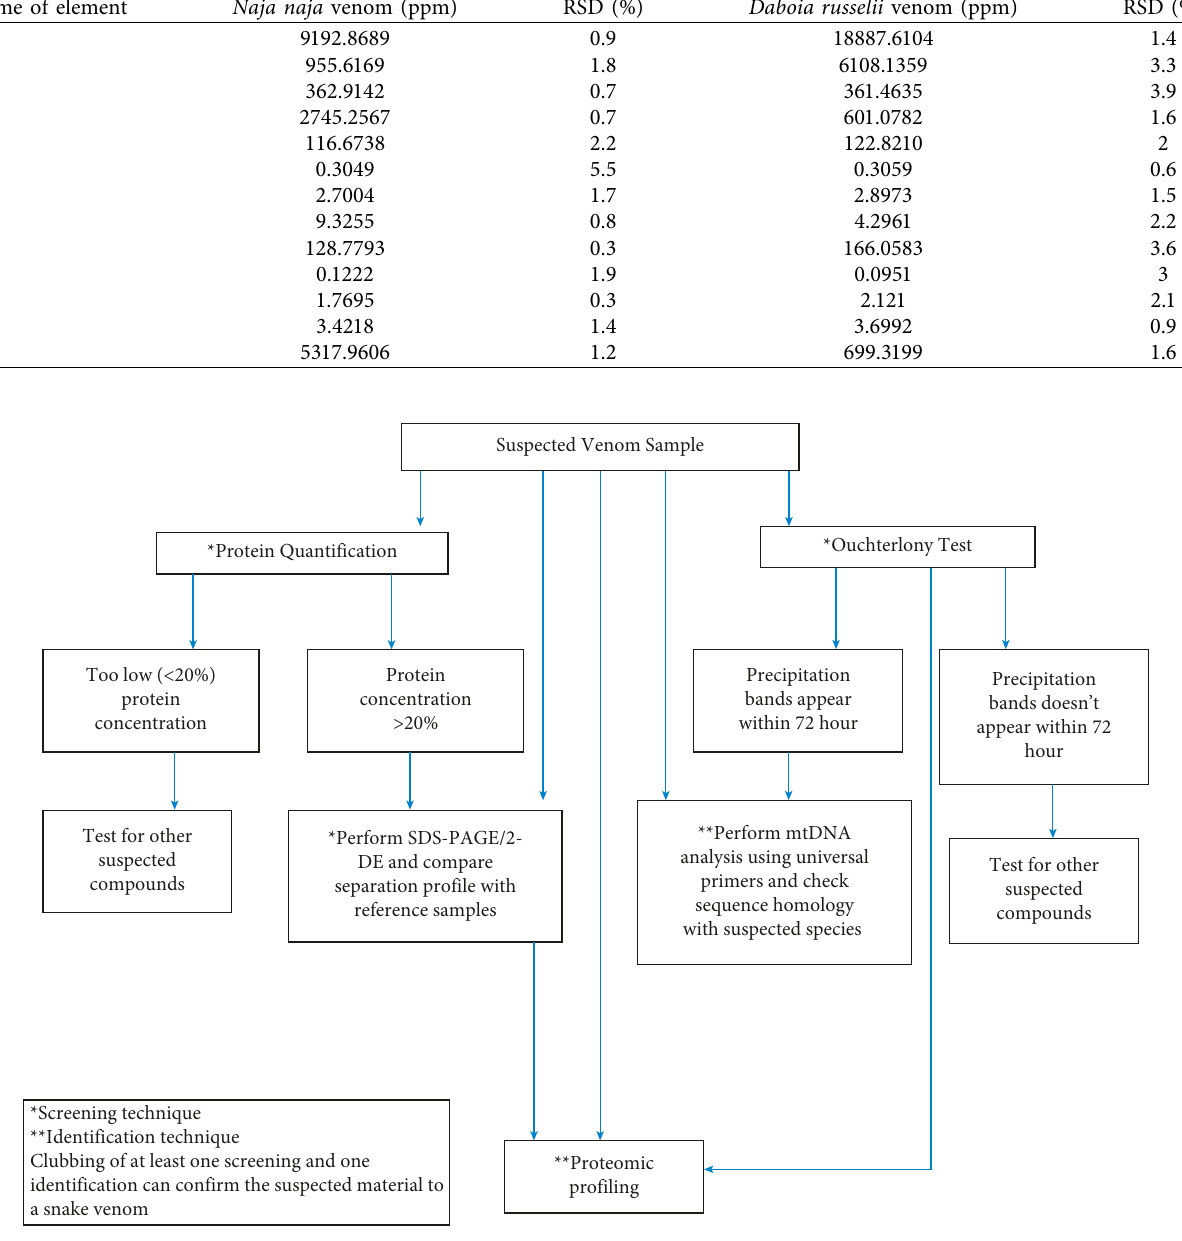
Figure 6: The proposed template for screening and identification of suspected snake venoms in forensic